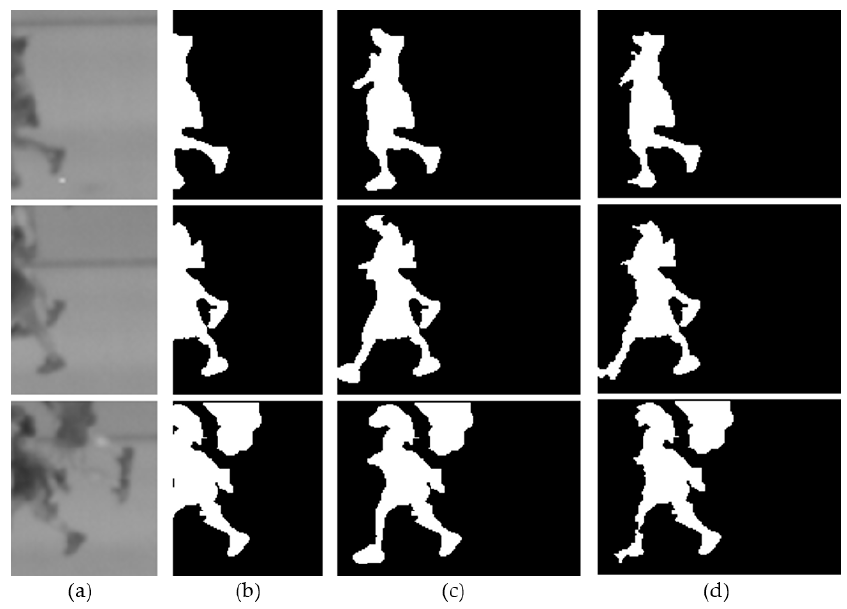
Figure 20. Example images of human segmentation from fold-1: ( a ) original images; segmentation results using ( b ) original images and ( c ) GT images; and the images predicted by ( d ) the proposed method.